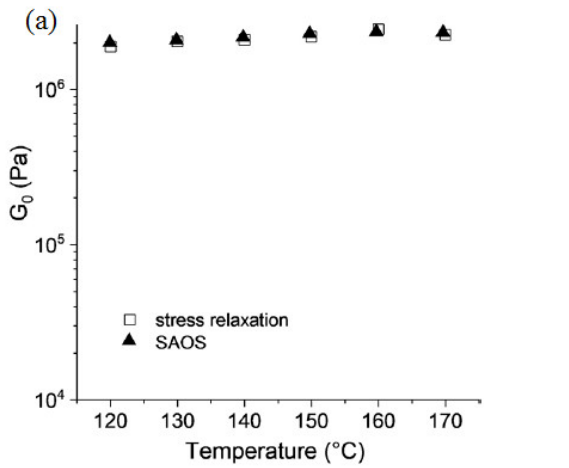
Figure 9. Dependences of the relaxation modulus G 0 on temperature, obtained by the methods of stress relaxation (1) and low-amplitude vibrational shift (2) for associative I ( a ) and dissociative II ( b ) polymers. Reprinted with permission from [83]. Copyright (2020) American Chemical Society.